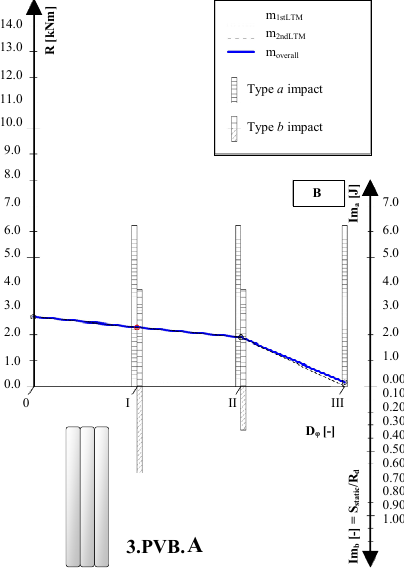
Figure 5: Element Safety Diagram for double layer, PVB-laminated, thermally tempered glass beam.